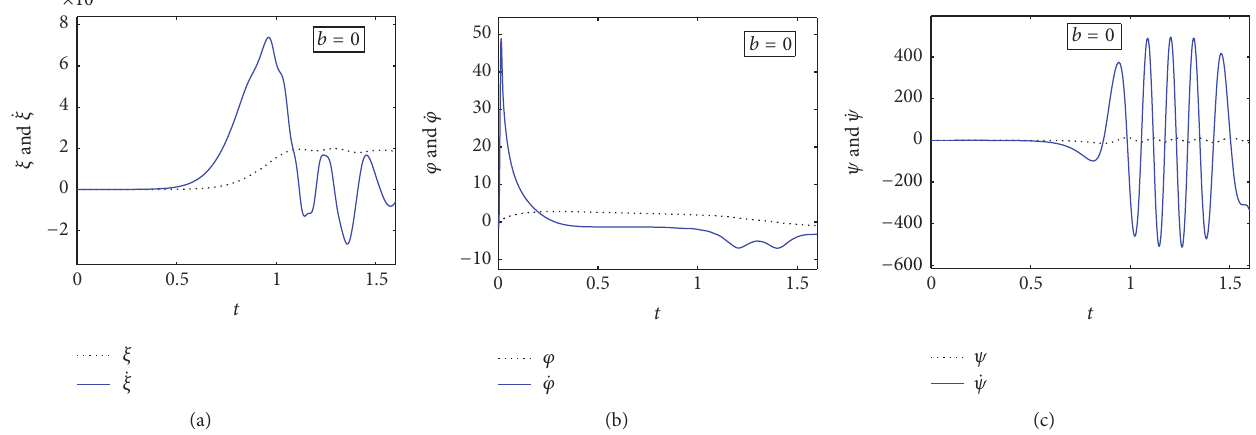
̇𝜉, ̇𝜑 , and ̇𝜓 via time 𝑡 , respectively, when